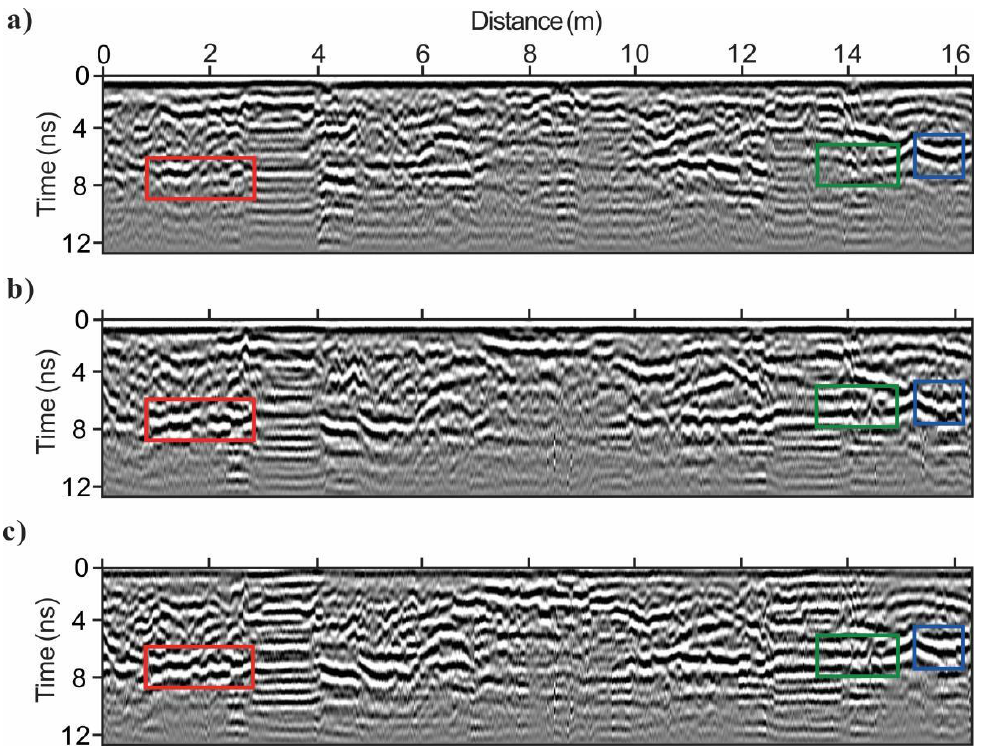
Figure 7. Inline profile of the time-lapse 3D GPR data on ( a ) 22 Jul., and ( b ) 30 Jul., ( c ) differenced profile.